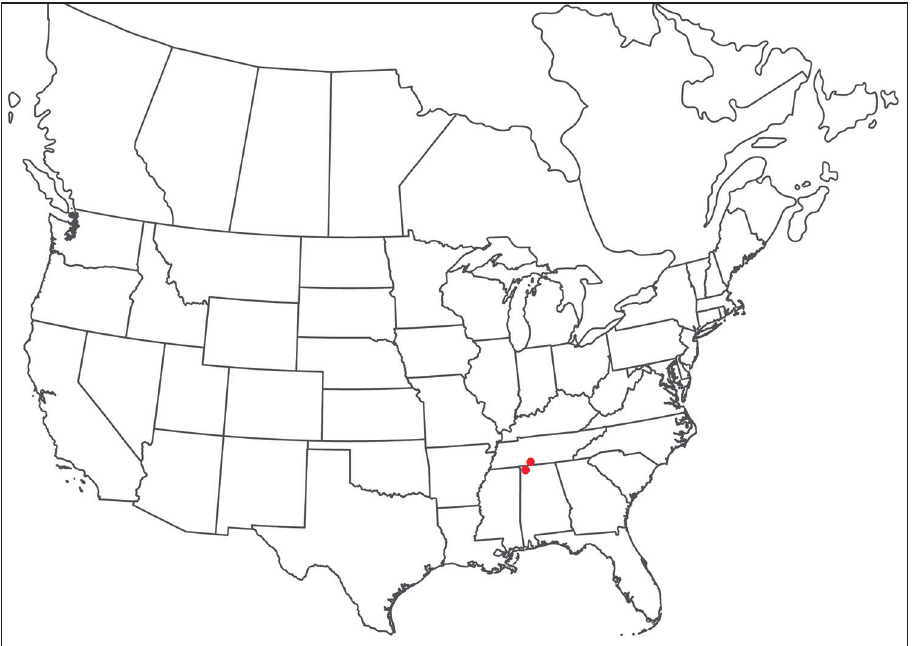
Figure 258. Torrenticola tysoni sp. n.